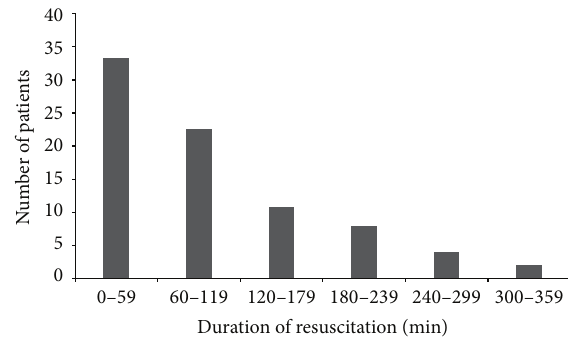
Figure 1: Duration of the cardiopulmonary resuscitation in the 82